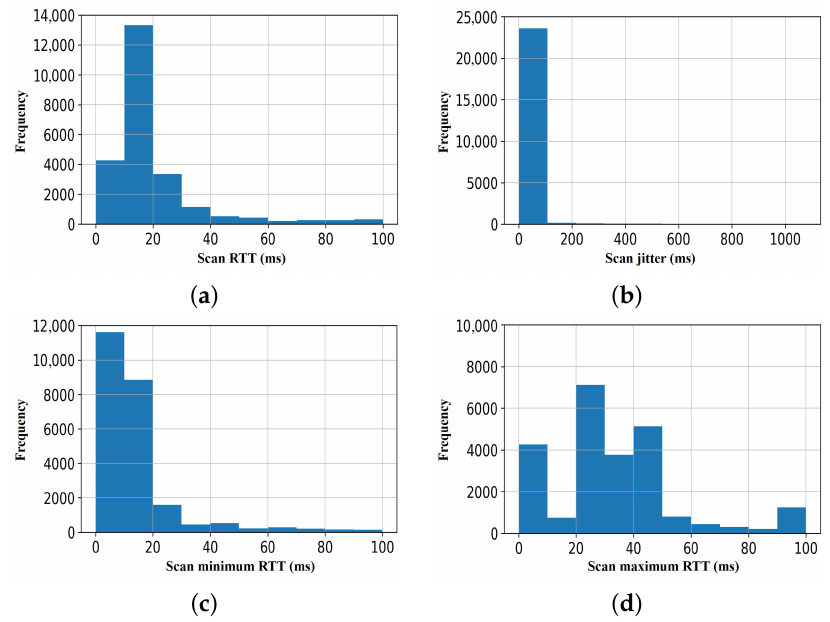
Figure 7. Scan response set 2: Data distribution using histogram of the scan traffic features. ( a ) Scan RTT; ( b ) scan jitter; ( c ) scan minimum RTT; ( d ) scan maximum